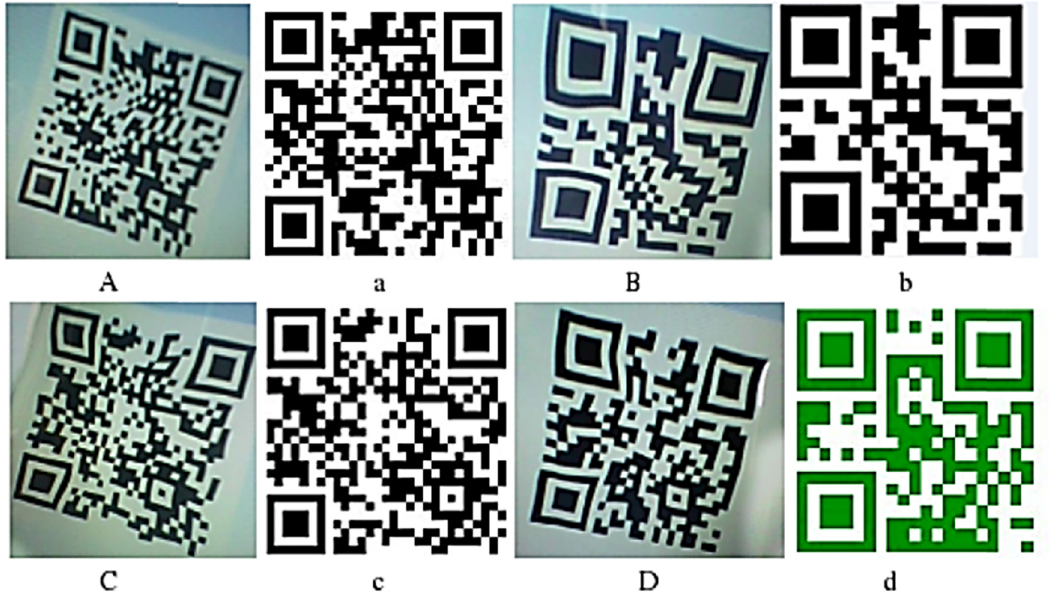
Figure 4: Sample picture collection indicated by capital ( A – D ) and the corresponding QR codes indicated by smalll ( a – d )